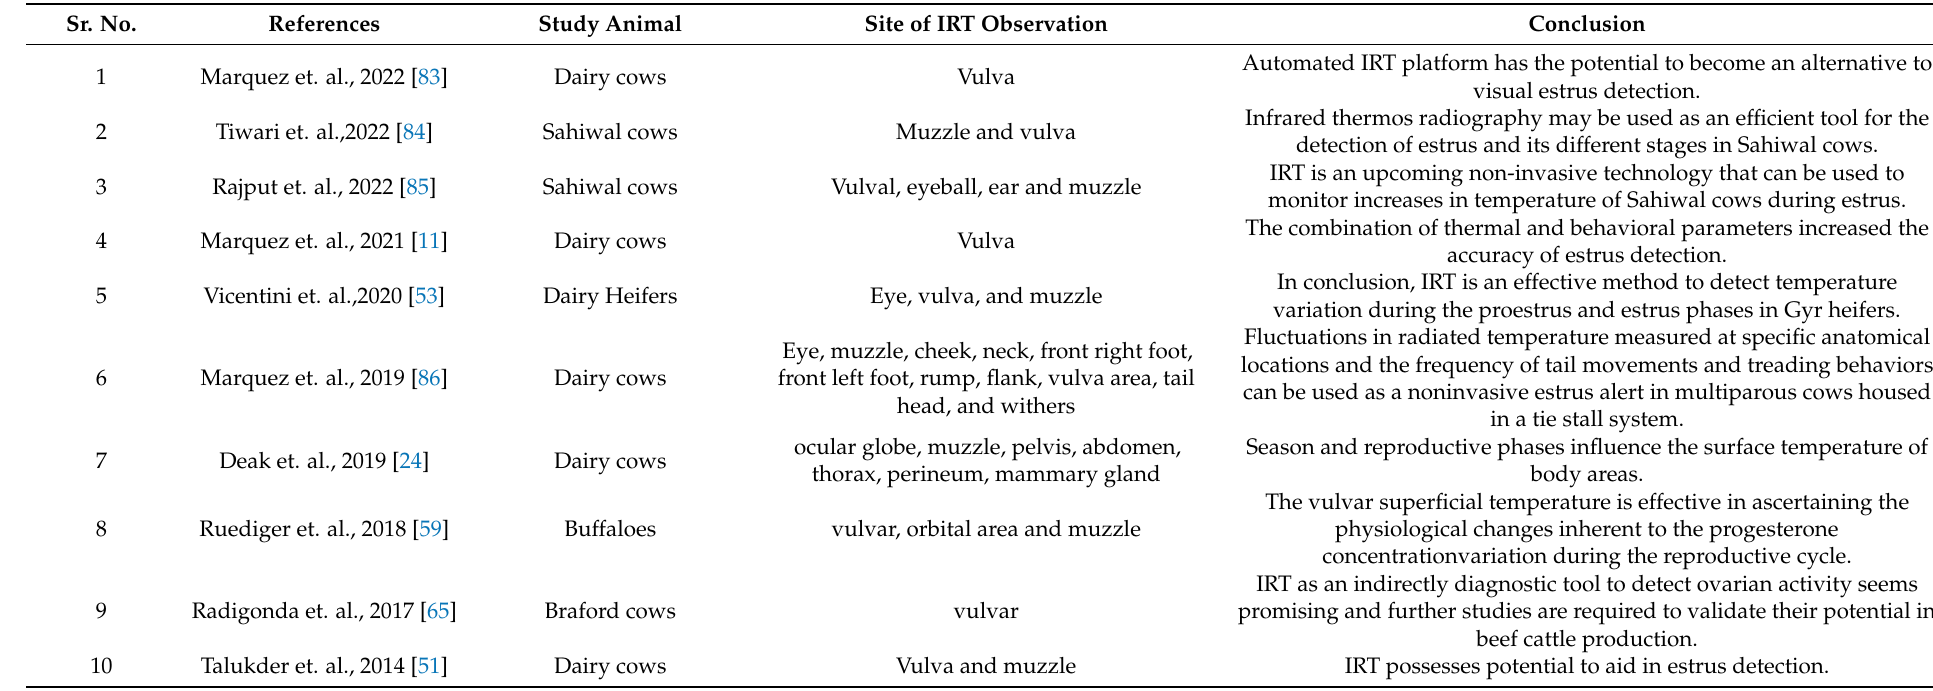
Table 2. Studies on application of Infrared Thermography (IRT) to detect estrus in cattle and